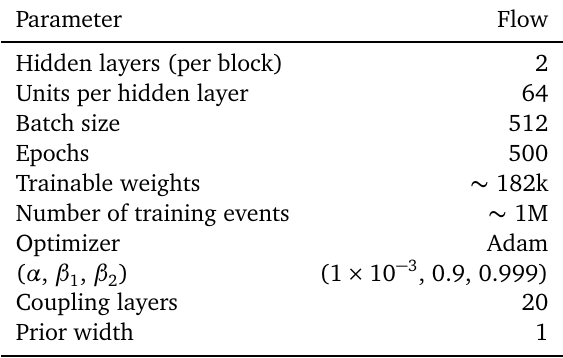
Table 2: Hyper-parameters for the Drell-Yan data set, implemented in P Y T ORCH (v1.4.0) [ 74 ]